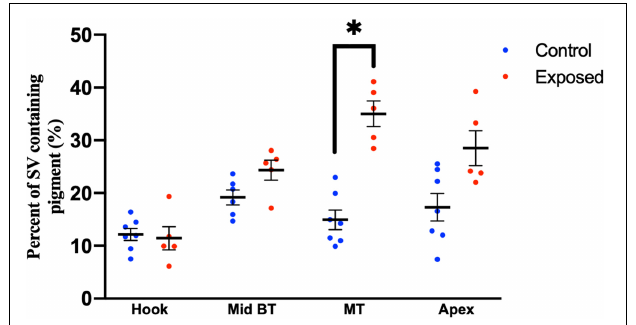
FIGURE 4 | Percentage of the stria vascularis containing pigment within adult (20–32 month) mouse temporal bone specimens with or without noise exposure. Error bars indicate standard error. ∗ Adjusted p -value < 0.05.